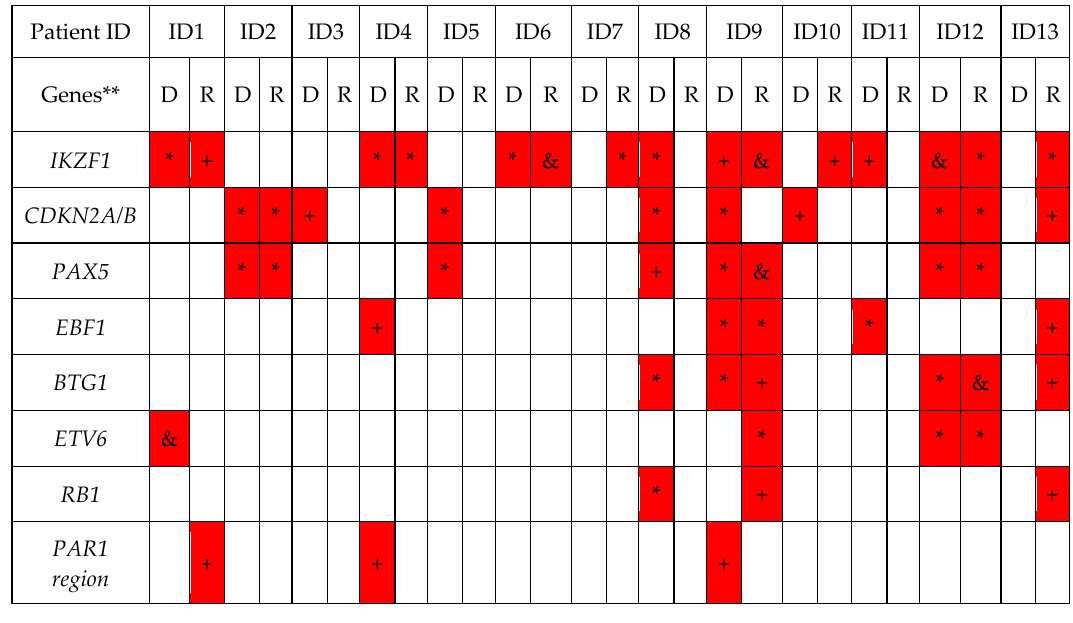
Figure 3. Gene deletions identified by an integrative MLPA–aCGH analysis. ** The P335-B1 probemix contains probes for the following genes: IKZF1 (eight probes at 7p12.2), CDKN2A/B (three probes at